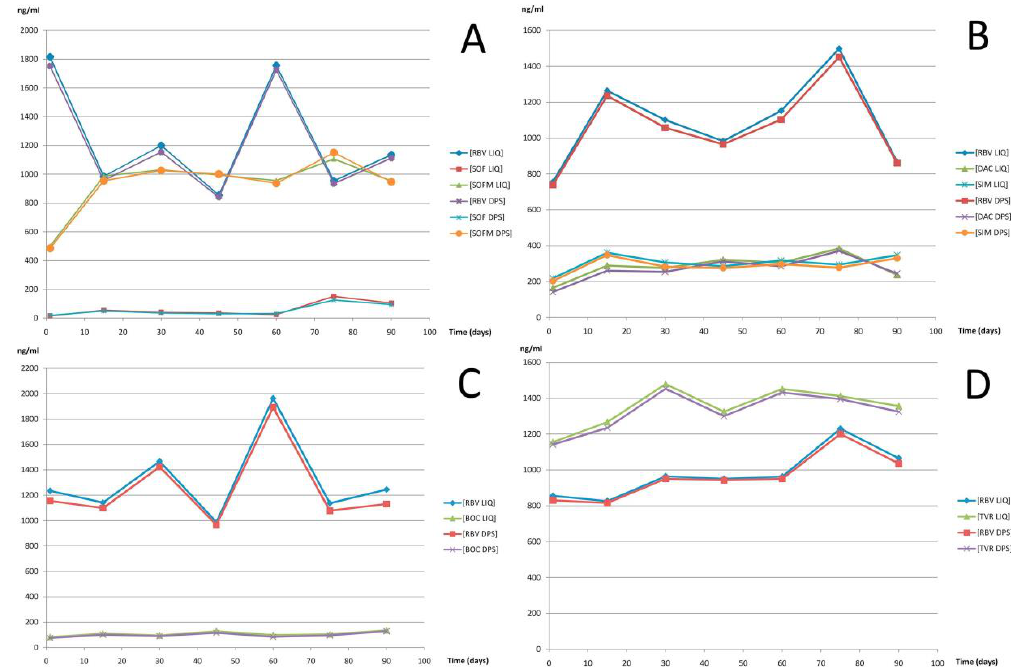
Figure 7. Time-course of the drug levels (measured both in liquid plasma and dried plasma spot (DPS) samples) in a patient under therapy. Time course of drug through concentrations in plasma samples from four different patients receiving different combined interferon-free antiviral therapies. Concentration of the drugs (ng/mL) are plotted vs. time (days) since the beginning of therapy. TDM was performed every other week for three months. ( A ). Blue diamond = liquid plasma ribavirin (RBV), purple cross = dried plasma spot (DPS) RBV, red square = liquid plasma sofosbuvir (SOF), light blue star = DPS SOF, green triangle = liquid plasma metabolite GS 331007 (SOFM) and orange circle = DPS SOFM concentration, respectively. ( B ). Blue diamond = liquid plasma RBV, red square = DPS RBV, green triangle = liquid plasma Daclatasvir (DAC), purple cross = DPS DAC, light blue star = liquid plasma Simeprevir (SIM) and orange circle = DPS SIM concentration respectively. ( C ). Blue diamond = liquid plasma RBV, red square = DPS RBV, green triangle = liquid plasma Boceprevir (BOC), purple cross = DPS BOC concentration, respectively. ( D ). Blue diamond = liquid plasma RBV, red square = DPS RBV, green triangle = liquid plasma Telaprevir (TVR), purple cross = DPS TVR concentration, respectively [94].